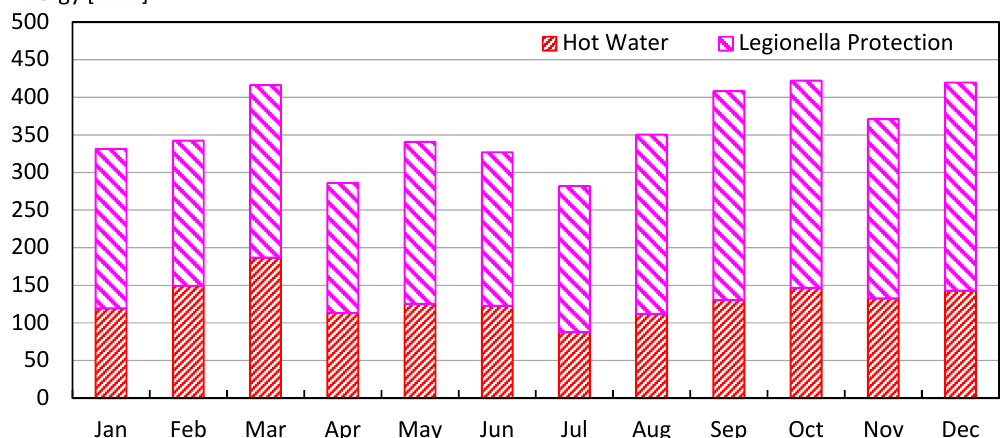
Figure 29. Measured monthly electrical energy consumption of hot water production and legionella protection system for 2015.